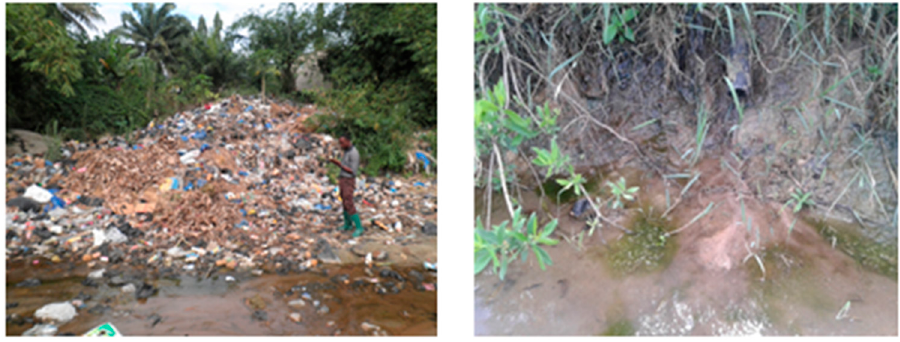
Figure 5. Solid and liquid waste dumping along Mbezi River. The photos were taken with permission on 24 June 2016.